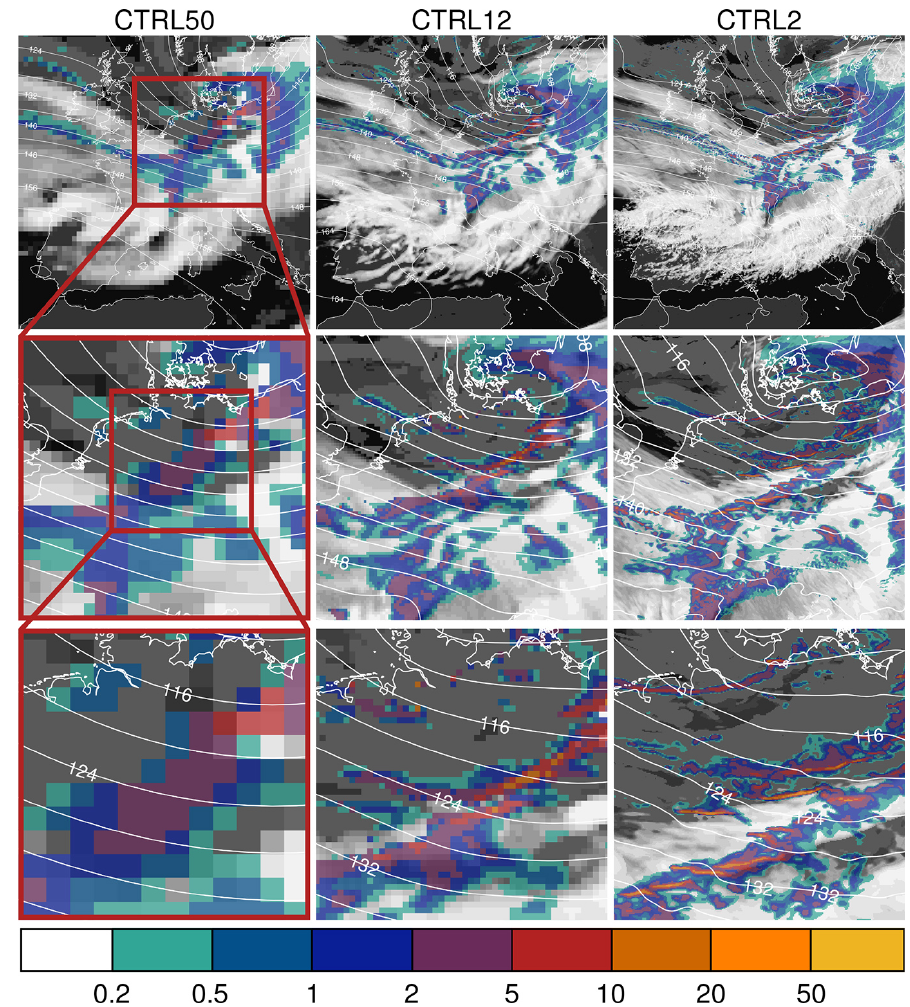
Figure 5. Snapshot of Kyrill II on 18 January 2007, 18:00UTC. The colored shading indicates the rain rate [mmh − 1 ], the white shading a cloud cover visualization (section 2.4.1), and the white contours geopotential height at 850hPa [gpdm] using a line spacing of 4gpdm; (left) CTRL50 simulation, (middle) CTRL12 simulation, and (right) CTRL2 simulation. The red boxes in the left-hand column denote zoomed areas. An animation of this episode is available on the internet (Leutwyler et al.,